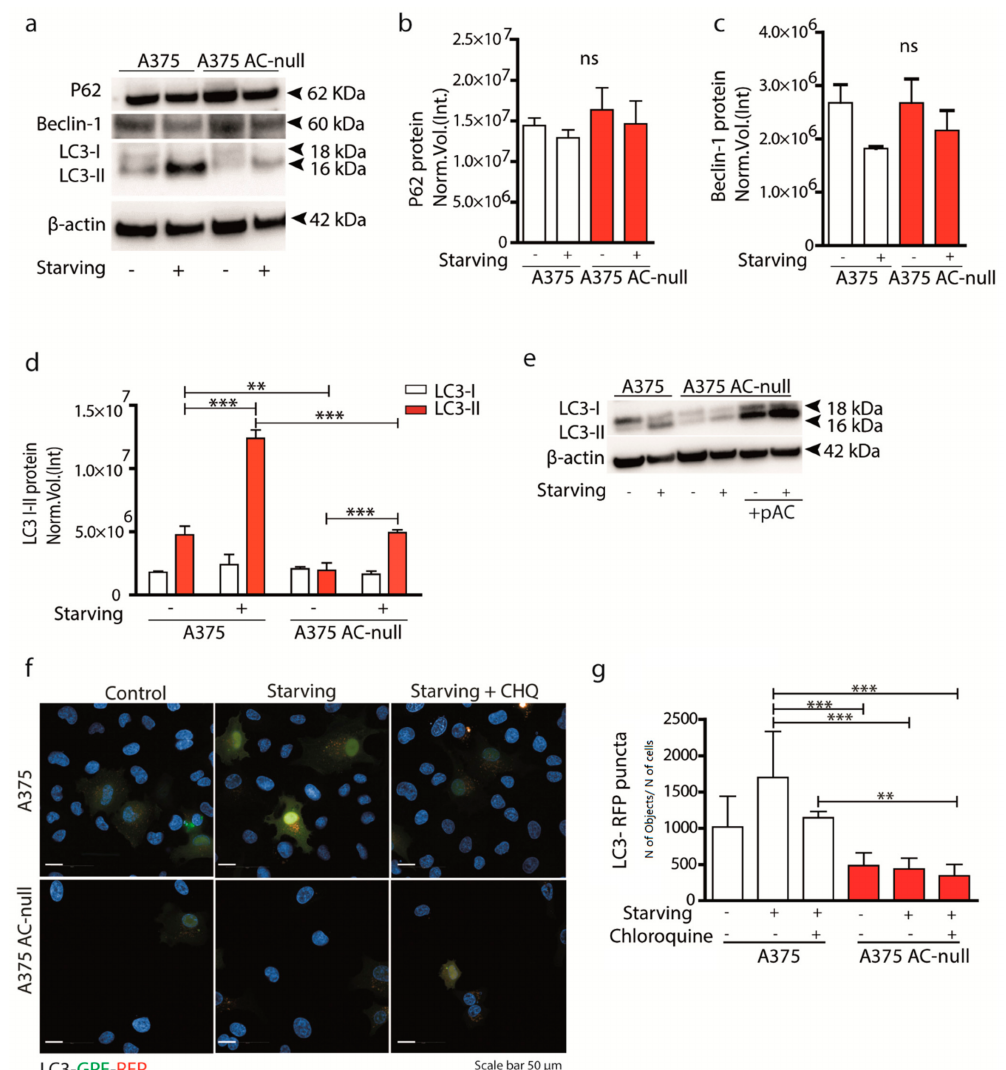
Figure 2. AC ablation deregulates autophagy during glucose starvation. ( a ) Western blotting with anti-P62, anti-Beclin-1 and anti-LC3 I-II antibodies on A375 and A375 AC-null cell lysates under baseline conditions and after 24 h of glucose starvation. ( b – d ) P62, Beclin-1 and LC3 I-II Western blot quantification on A375 and A375 AC-null cells, data are expressed as mean ± SD (** p < 0.01; *** p < 0.001, Two Way-ANOVA, with Bonferroni post hoc test). ( e ) Western blot showing